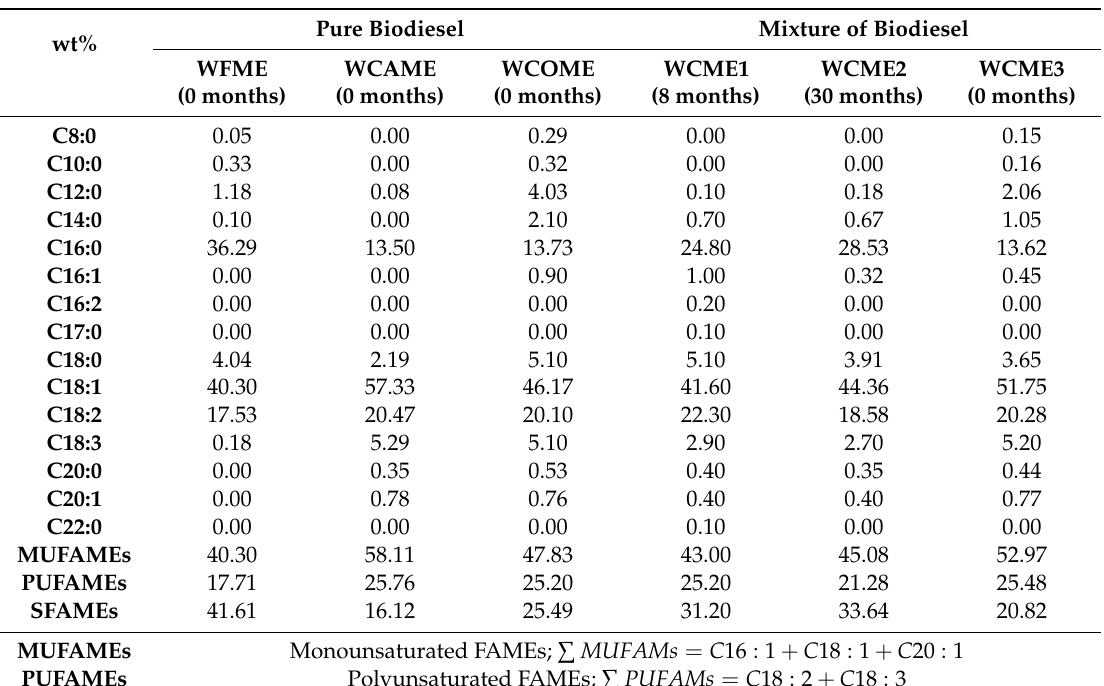
Table 1. Acid methyl ester composition (wt%) of pure biodiesel and their mixture fuels.